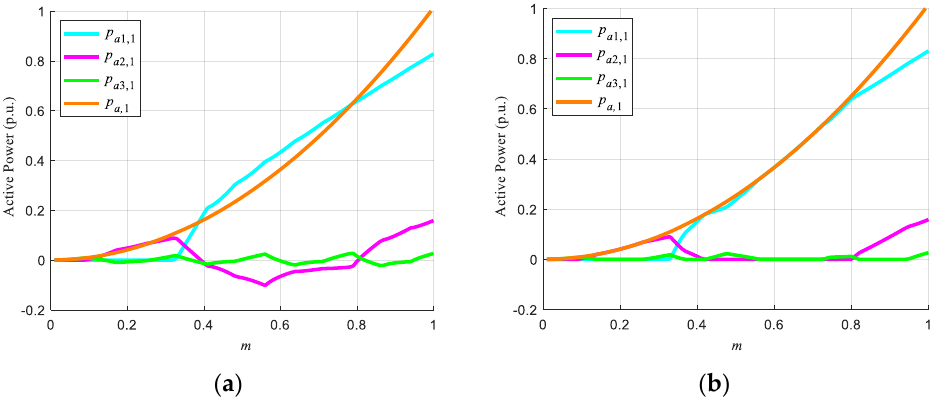
Figure 3. Active power distribution. ( a ) 27-level single—phase asymmetric inverter with regeneration, ( b ) 27-level single— phase asymmetric inverter without regeneration.